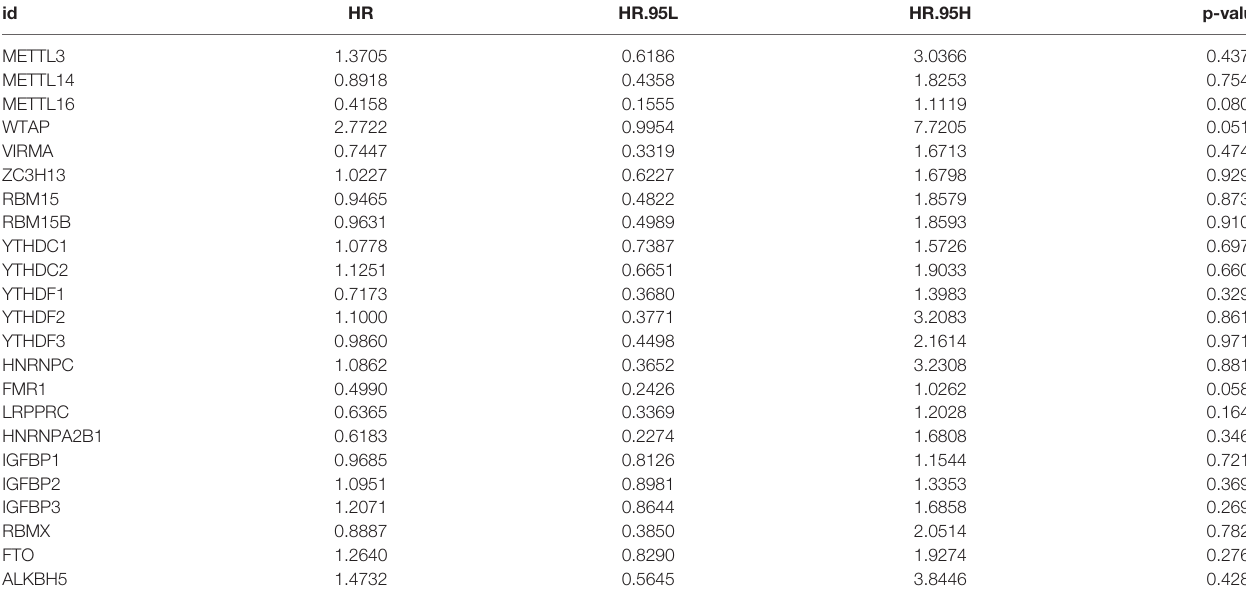
TABLE 1 | Analysis of 23 m6A regulatory factors through univariate Cox regression. id HR HR.95L HR.95H